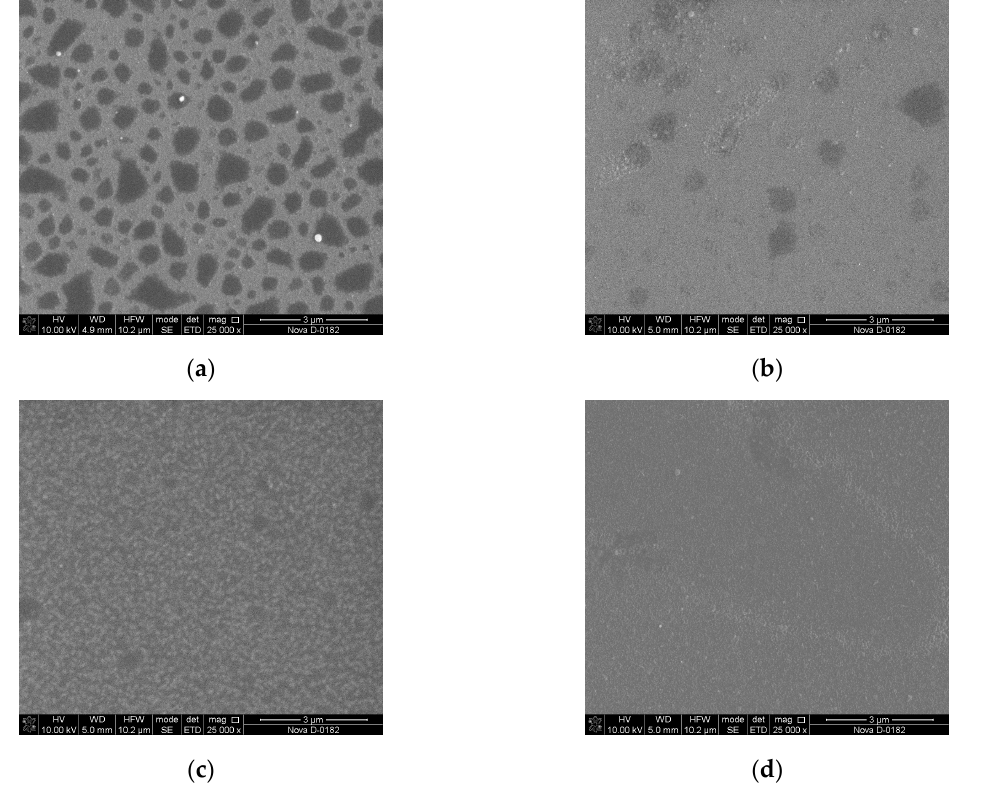
Figure 8. Scanning electron microscopy (SEM) images of LiNbO 3 films grown by PLD at different oxygen pressures: 1 × 10 − 5 Torr ( a ), 1 × 10 − 4 Torr ( b ), 1 × 10 − 3 Torr ( c ), 1 × 10 − 2 Torr ( d ).